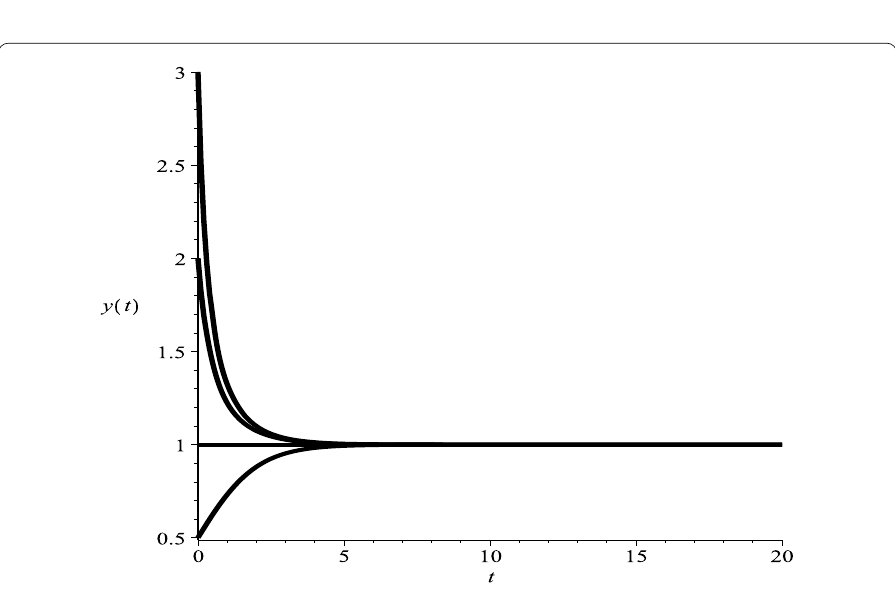
Figure 7 Dynamics behavior of the third component y ( t ) of system (5.1); here we take k = 0.2 and the initial conditions (